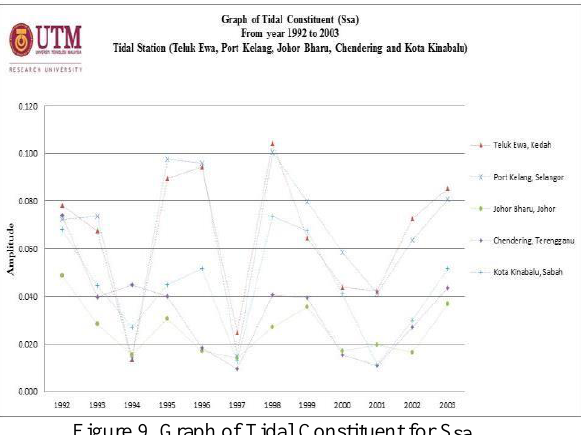
Figure 9. Graph of Tidal Constituent for Ssa Figure 9 show that the graph of tidal constituent for Ssa. The pattern for the value of amplitude for Ssa can be seen which is there are big reduction value of amplitude in 1997. Based on this study, there is occurrence of El-Nino in 1997 which is every station approaching the point to the same place. There are big effects that can be seen of El-Nino for Ssa compare to the tidal constituent of Sa because Ssa Figure 7. Graph of Tidal Constituent for O1 representing a semi-annual cycle of the mean sea level so there are two cycles per year. There need 185 days which is approximately to 6 months of data observation to generated this tidal constituents. The effects of Ssa can be seen clearly in 1997 because the period of phenomenon El-Nino and La-Nina occurs in 6 months. Figure 10, 11 and 12 represent the graph plotted on value of amplitude for the tidal constituent of Mm, Mf and MSf. This tidal constituent can be classified as the long period ocean tide constituent which is it can be generate based on the long period of observation. The tidal constituent of Mm representing a monthly cycle of the mean sea level while Mf representing the fortnightly constituent. This tidal constituent only limited to those latitude within ±66 degrees which is the station chosen included within that latitude. Figure 10 shows the graph plotted based on tidal constituent of Mm. There are no effects of El-Nino and La-Nina that can be seen